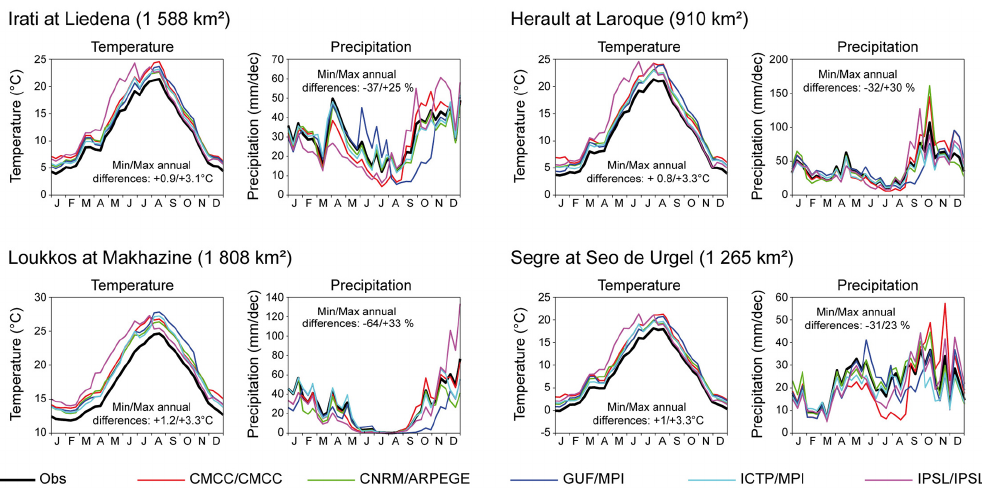
Figure 3. Changes in mean seasonal temperature and precipitation at the 2050 horizon compared to the reference period. The values ex- pressed in ◦ C and % correspond to the differences between bounds of variation in comparison to mean annual observations of temperature and precipitation.